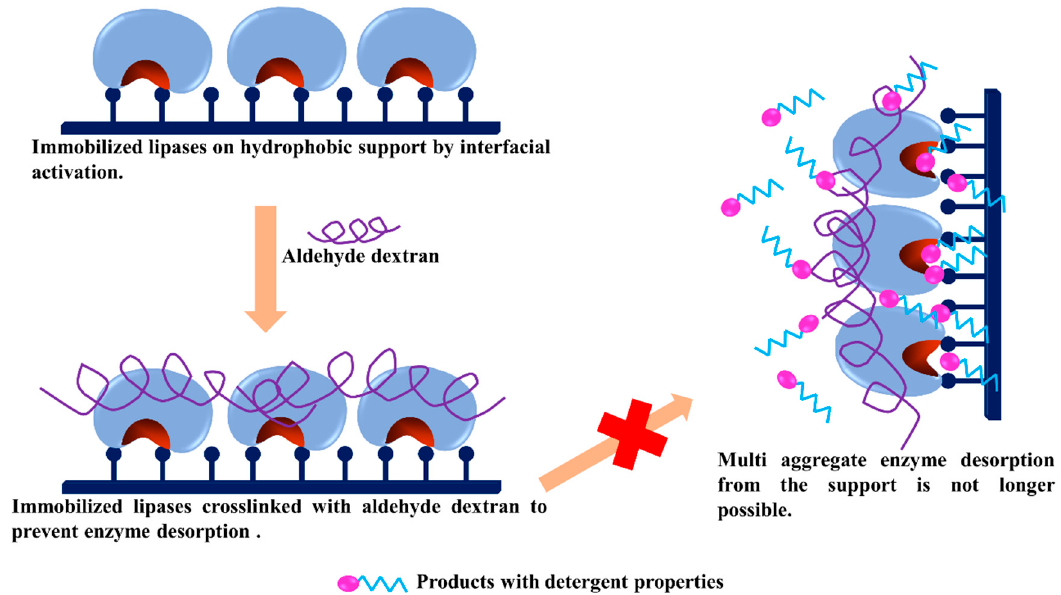
Figure 21. Intermolecular crosslinking of lipases immobilized on hydrophobic supports to prevent their release during operation.